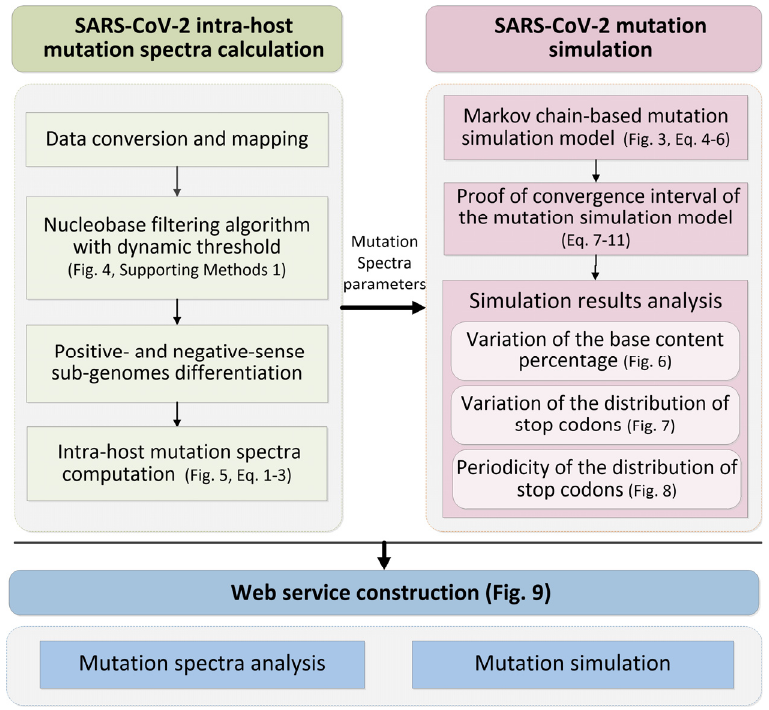
Figure 1. The workflow of the